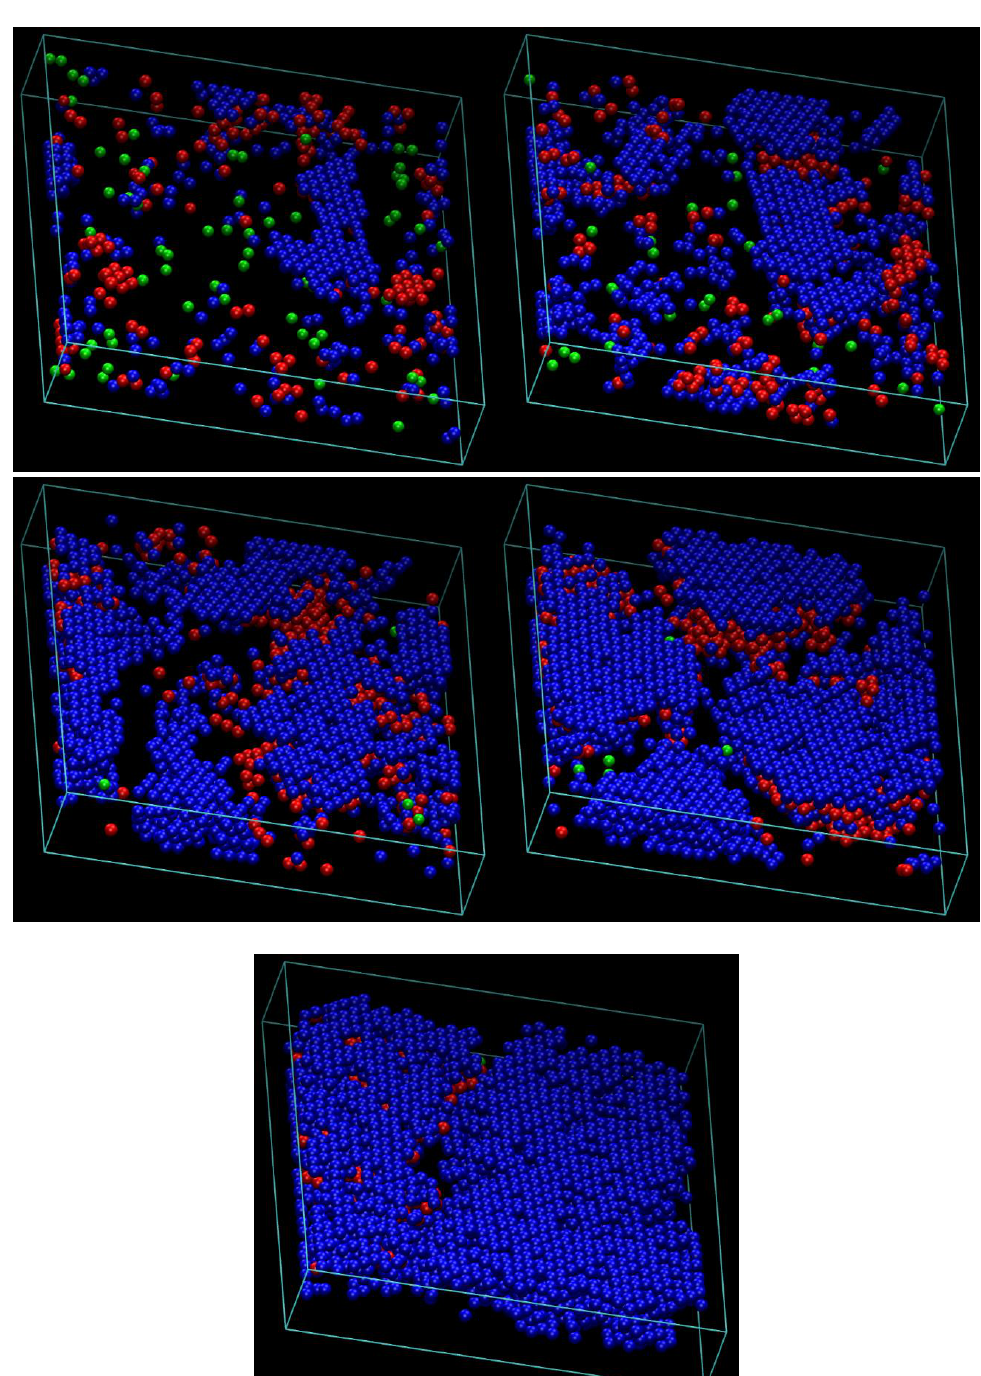
Figure 4. Snapshots of the 10-chain N mon = 1000 system at φ = 0.55 under plate-like confinement with cell anisotropy index, ζ = 5 and interwall distance, D wall ≈ 7. Top: very early in the simulation (10 9 MC steps); middle: (left) 2 × 10 10 and 5 × 10 10 (right) MC steps; bottom: 12 × 10 10 (left) and at the end of simulation, 14 × 10 11 (right) MC steps. Monomers with HCP, FCC and fivefold similarity as identified by the CCE norm, are shown in blue, red and green, respectively. All other, “amorphous” sites do not appear for clarity. Image created with the VMD software [134]. (please see supplementary materials for 3D